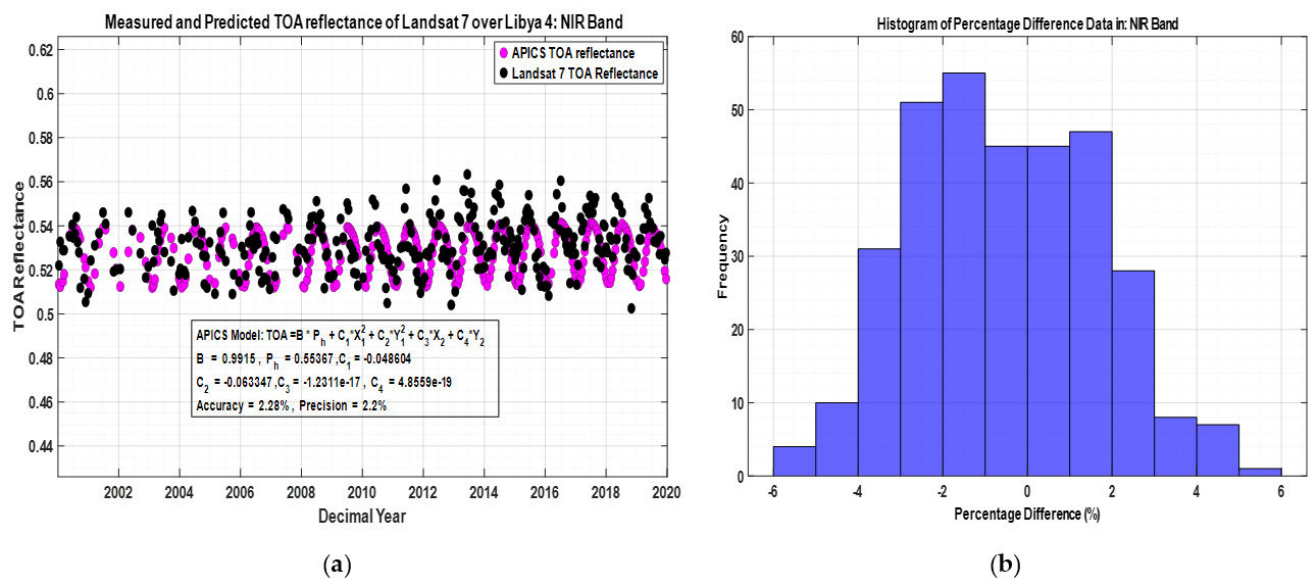
Figure 11. ( a ) L7 observation over Libya 4 (black circle) and model prediction (magenta circle) in NIR band; ( b ) Percentage Difference analysis plots of the model in the NIR band, Landsat